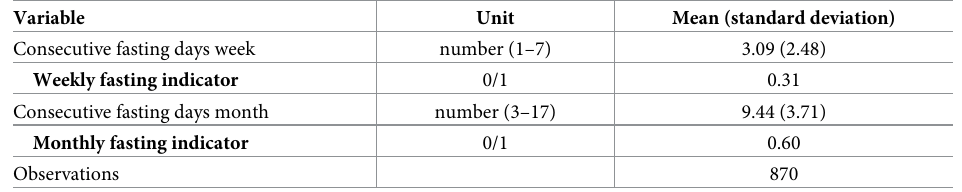
Table 3. Descriptive statistics of the constructed fasting indicators.